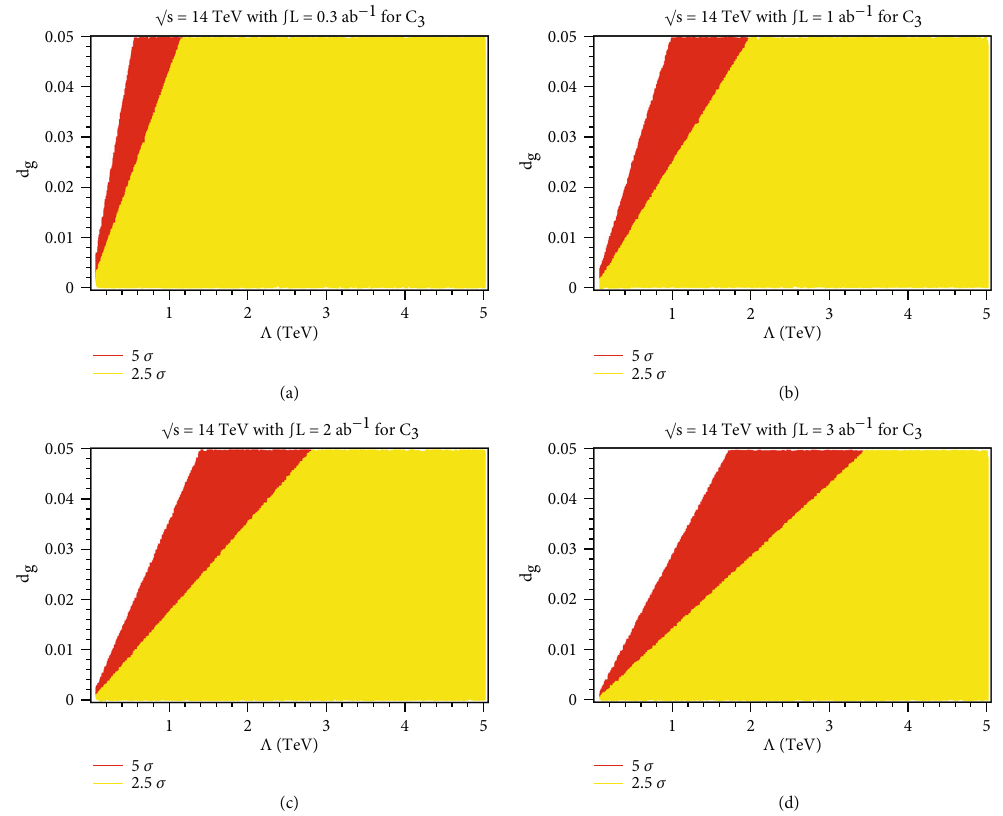
ffiffiffi p at = 14TeV energy at LHC for an integrated luminosity of (a) 0 : 3 ab − 1 , (b) 1 ab − 1 , (c) 2 ab − 1 , and (d) S 3